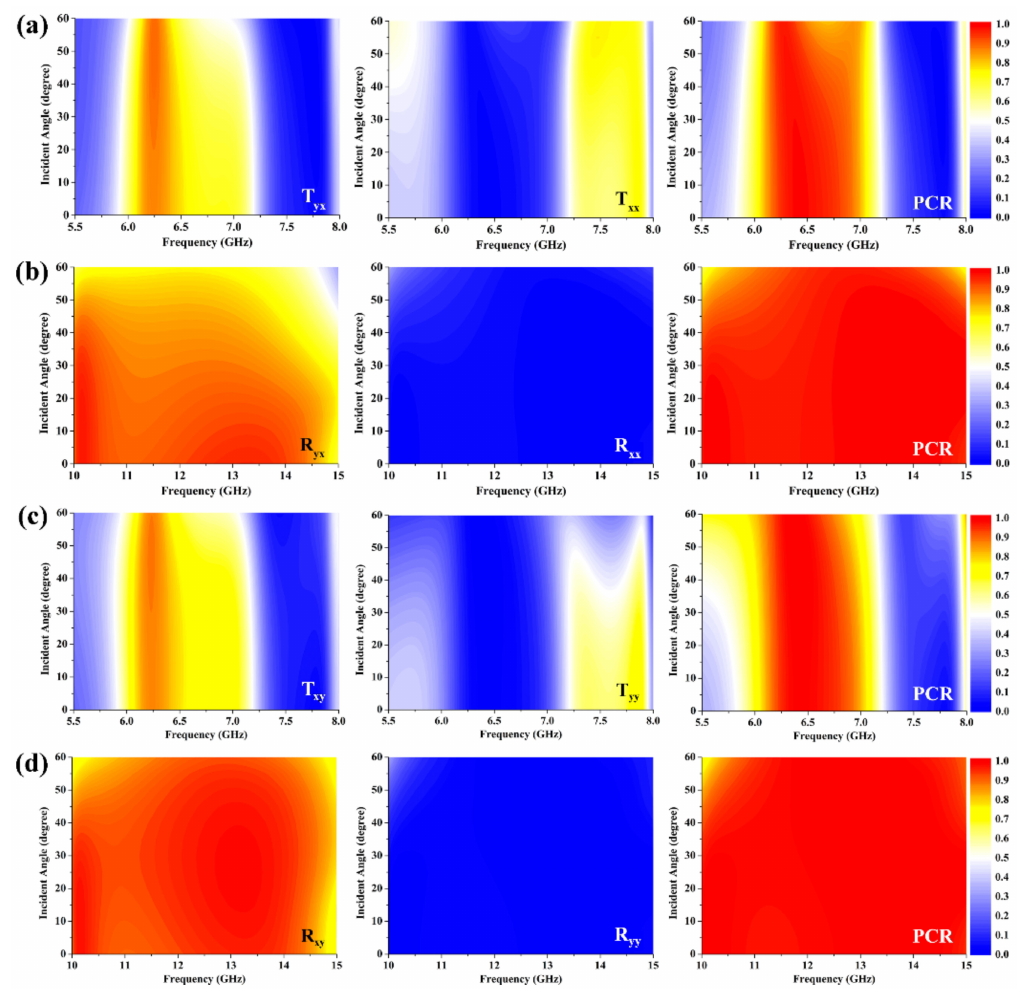
Figure 6. The effects of incident angle on the electromagnetic properties of the metagrating for the linearly polarized incident waves. The results of the metagrating in ( a ) transmission and ( b ) reflection modes under x -polarization incidence. The results of the metagrating in ( c ) transmission and ( d ) reflection modes under y -polarization incidence. At oblique incidence, the x - and y -polarization waves actually represent the TM and TE waves, respectively. In the simulations, the incident angle is increasingly tuned by a step of 5 ◦